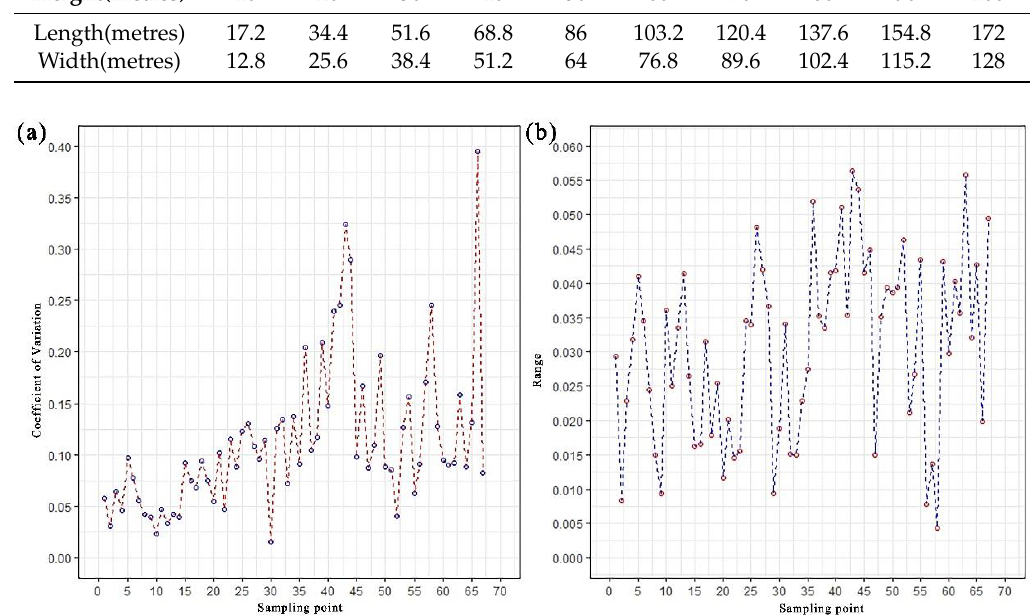
Figure 5. Impact of scale on extracting FVC: ( a ) the change in the coefficient of variation, and ( b ) the range of FVC extracted from 10 photos taken at 10–100 metres above each sample point.